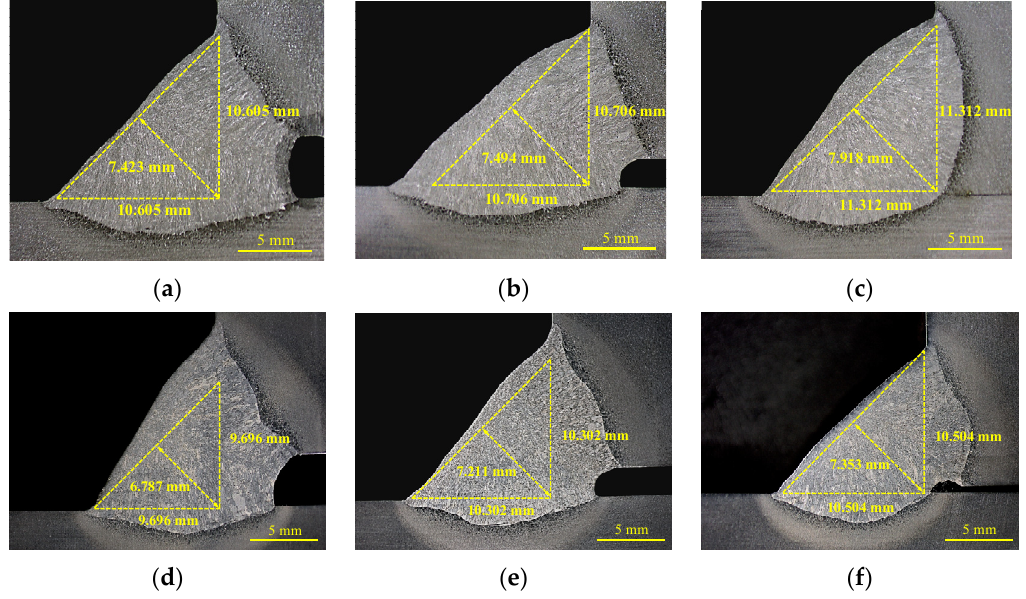
Figure 17. Weld bead cross-sectional comparison with and without quality control (optimal conditions for 4 mm gap): ( a – c ) without real-time weld quality control, and ( d – f ) with weld quality control based on the proposed DNN method.